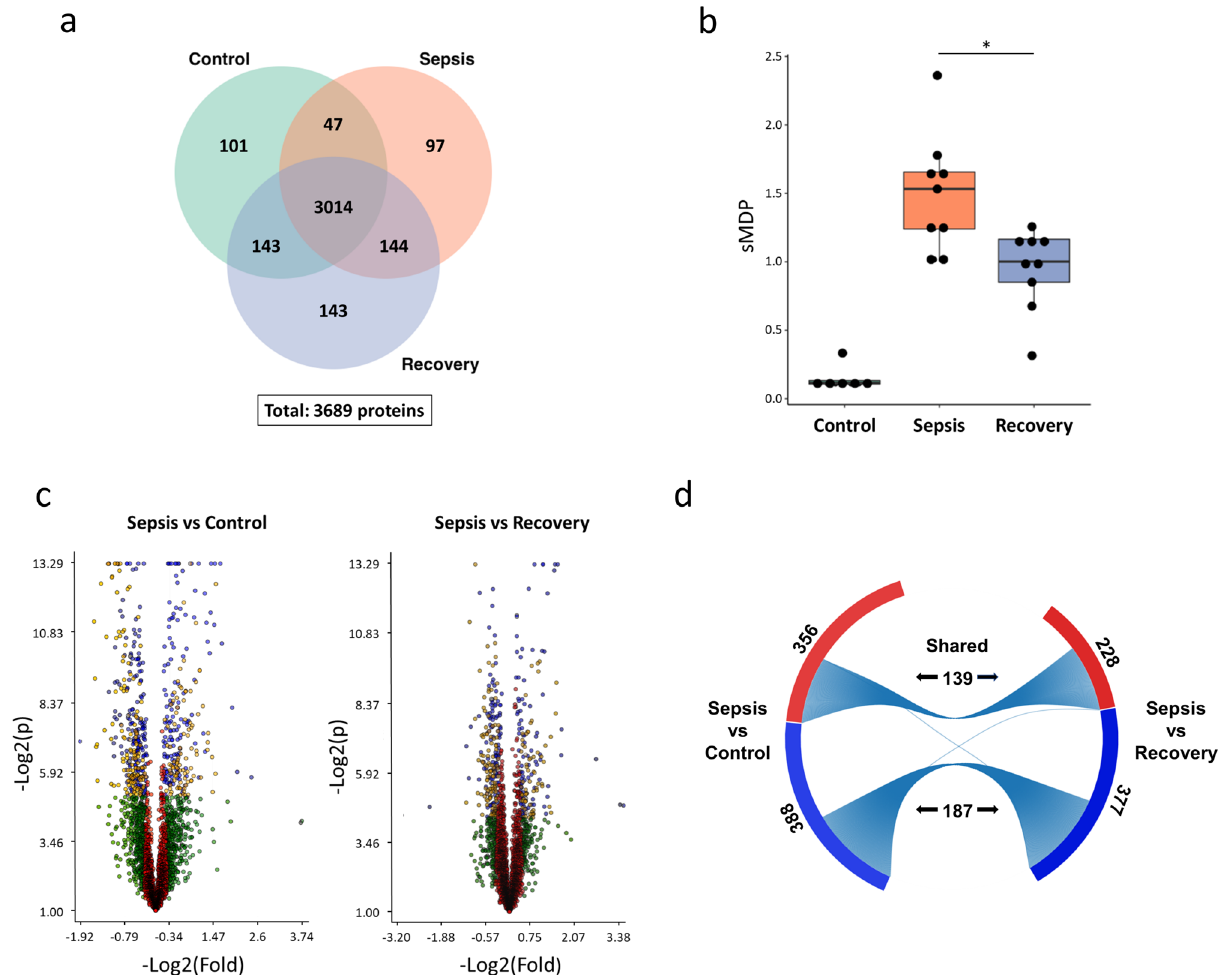
Figure 1. Alterations in the proteome of monocytes in the acute phase of sepsis (Sepsis group), compared with the recovery phase (Recovery group) and healthy subjects (Control group). ( a ) Total, unique, and shared protein identifications among the experimental groups. ( b ) Molecular degree of perturbation of the Sepsis end Recovery groups in relation to the Control group. The plot represents individual values with median and IQR per group. ( c ) Volcano plot of all shared proteins in the comparisons between the Sepsis and Control and Sepsis and Recovery groups. Each dot represents a protein mapped according to its log2 (fold change) on the y-axis and its − log2 (t-test p value) on the x-axis. The red dots indicate proteins that satisfy neither the fold-change cutoff nor the p value (0.05). Green dots depict protein entries that meet the fold-change cutoff but not the p value. Orange dots indicate proteins that satisfy both fold-change and p value but have low abundances, as determined by an additional stringency filter. Blue dots represent protein entries that met all statistical filters and were selected for further analysis. ( d ) Total and shared proteins significantly up (red bars) or down (blue bars)-regulated in the comparisons between the Sepsis and Control and Sepsis and Recovery